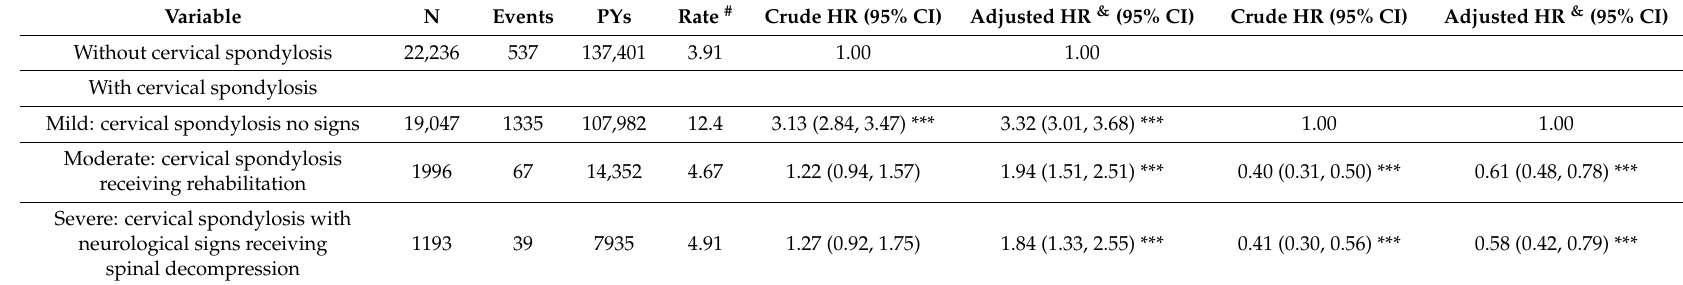
Table 5. Incidences and hazard ratios of arrhythmia for cervical spondylosis patients with and without treatment compared to patients without cervical